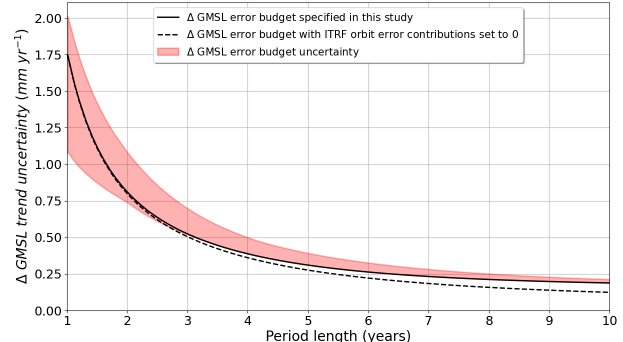
Figure 3. GMSL trend differences between S3B and Jason-3 and between S3A and SARAL/AltiKa over the December 2018 to March 2021 period. The black boxes show the GMSL trend un- certainties at 68%CL, and the grey boxes show the GMSL trend uncertainties at 90%CL.